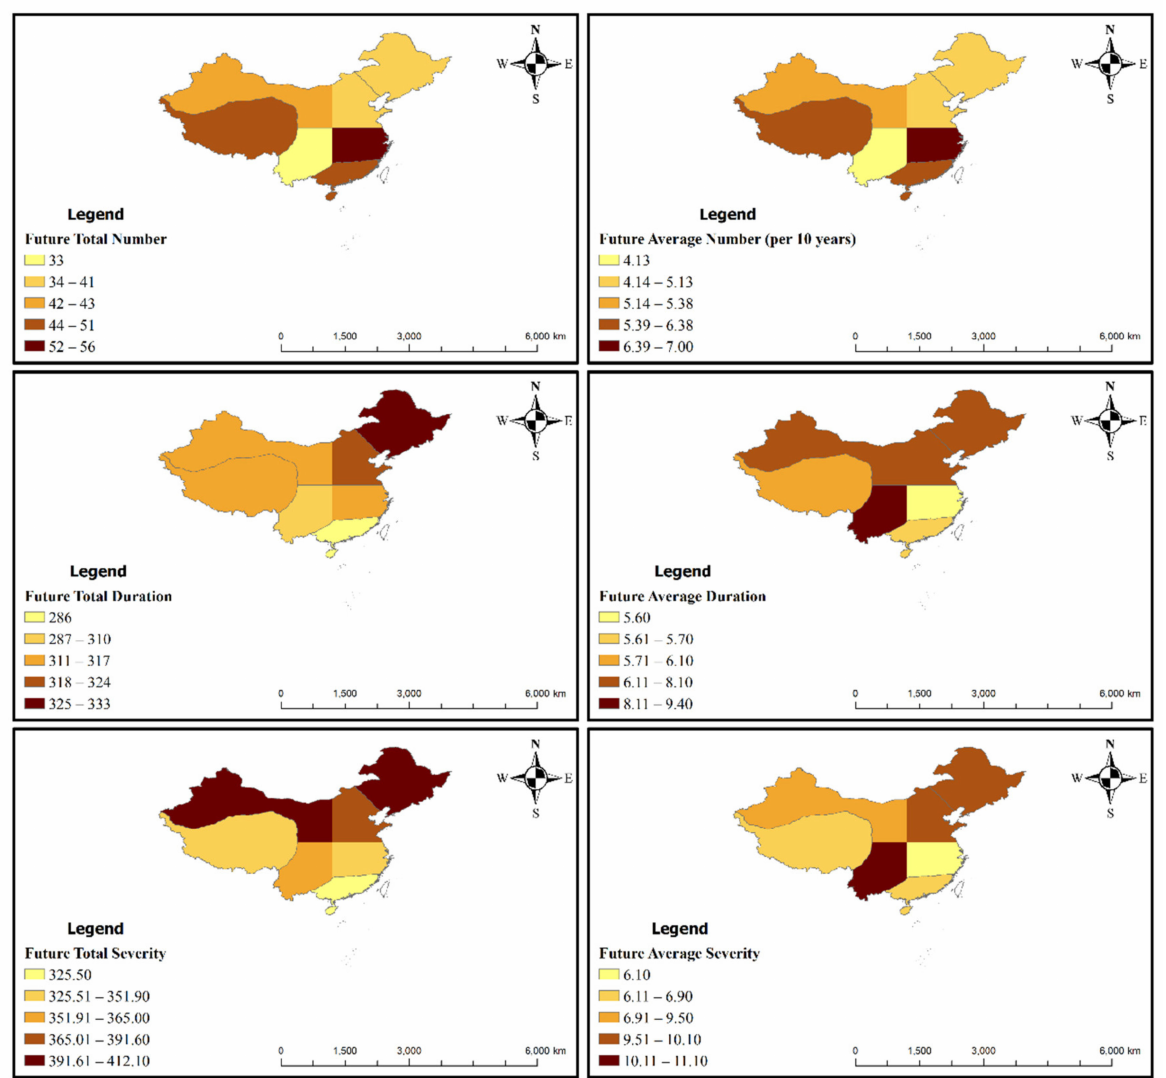
Figure 5. Spatial map of drought characteristics in the future